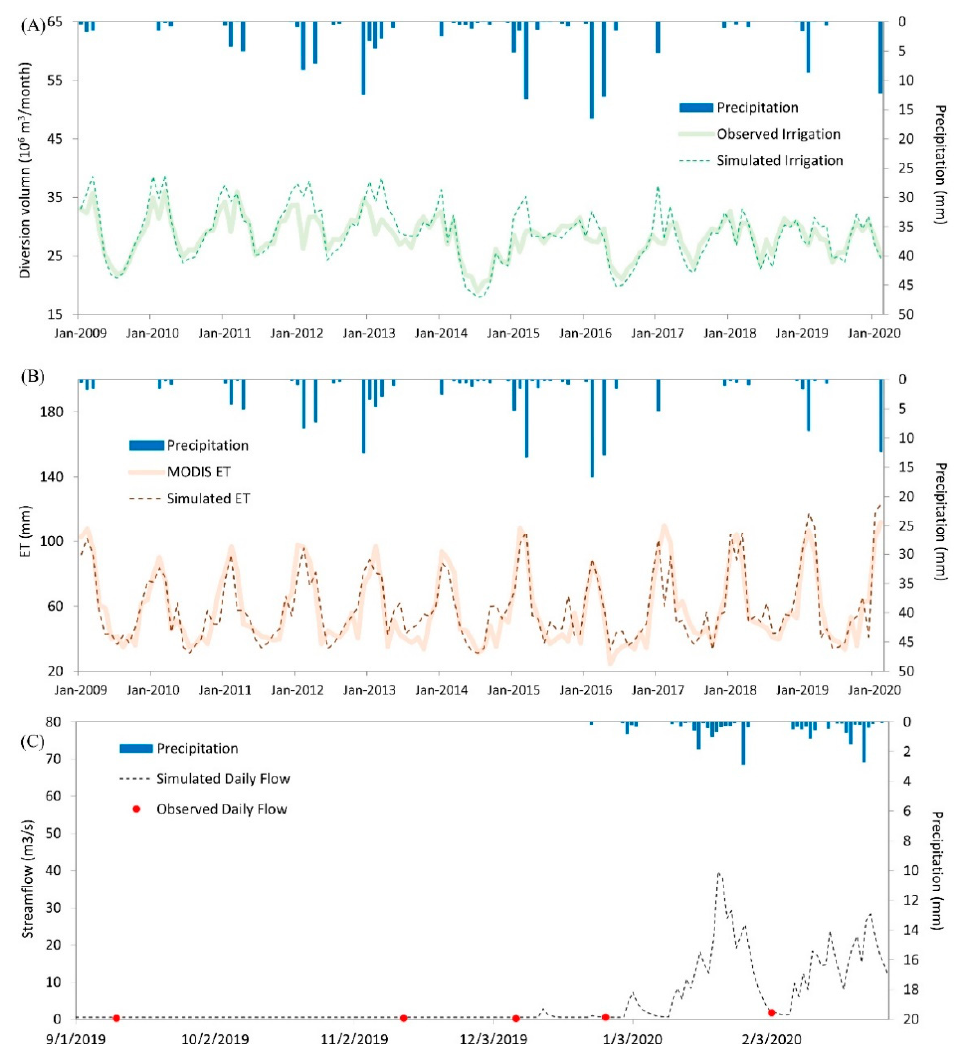
Figure 6. Comparisons of ( A ) the monthly SWAT simulated irrigation water and observed irrigation water calculated by canal diversion records, ( B ) the monthly SWAT simulated evapotranspiration (ET) and Moderate Resolution Imagine Spectroradiometer (MODIS) simulated ET in Majes region, ( C ) the daily SWAT simulated streamflow and observed streamflow downstream of Siguas River.